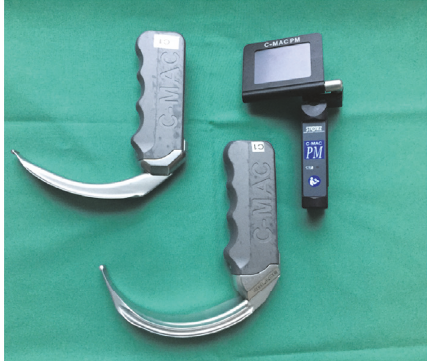
Figure 1: C-MAC PM (cid:2) . C-MACPM (cid:2) videolaryngoscope (right),D- Blade (cid:2) (middle), and Macintosh blade size 3